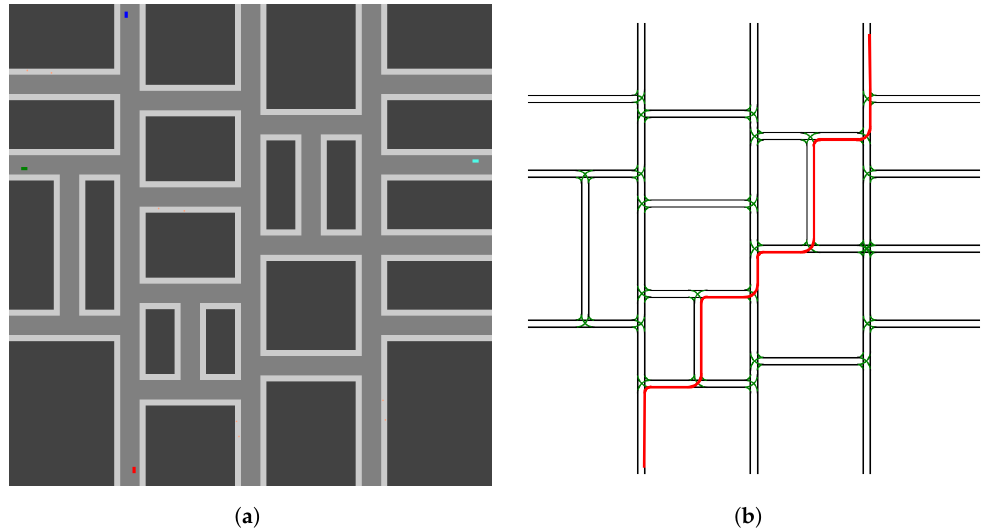
Figure 6. Sample driving environment including rectangular buildings, sidewalks, and cars (blue, cyan, red, and green rectangles) with shortest path trajectory. ( a ) Main environment and ( b ) Sample path (black and green lines representing road segments and shortest path in